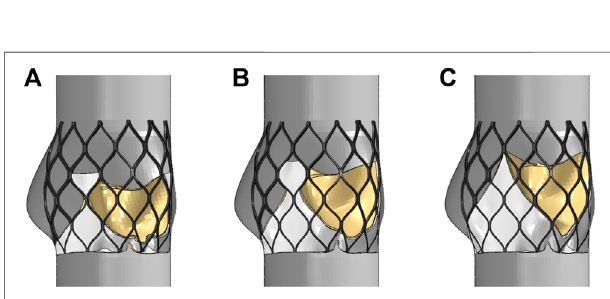
FIGURE6| Structuralmodelaftervalvestentintervention, (A) valvestent intervention of model A, (B) valve stent intervention of model B, (C) valve stent intervention of model